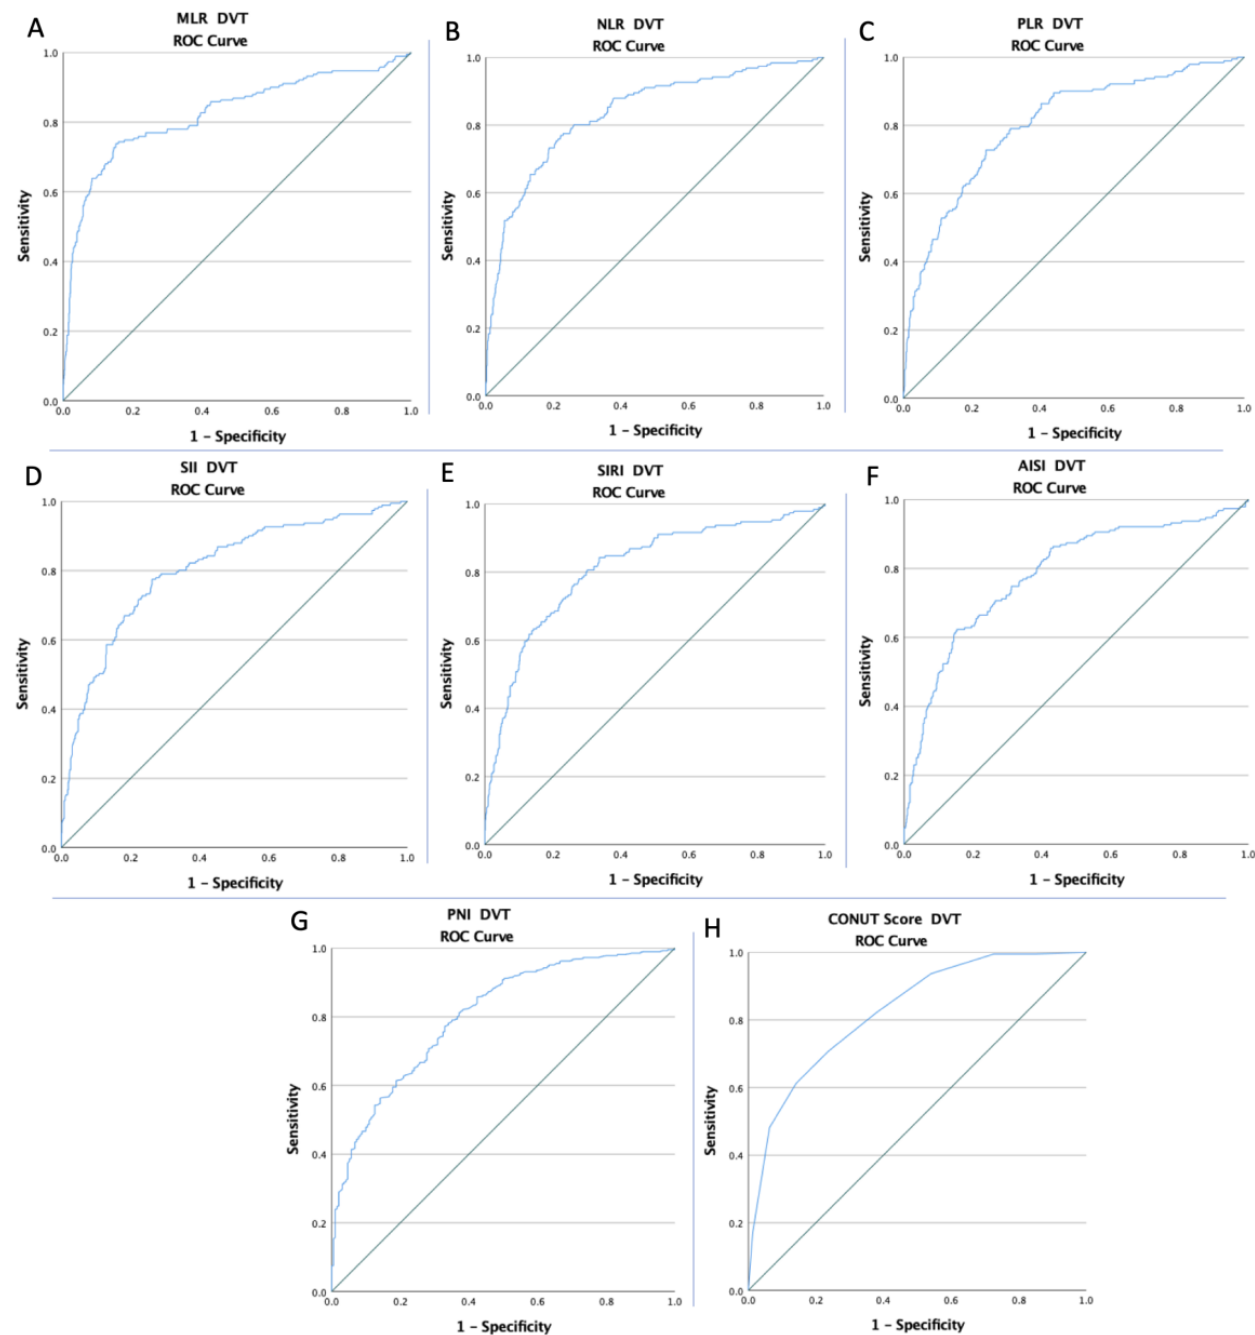
Figure 1. The ROC curve analysis concerning DVT risk ( A ) for the MLR (AUC: 0.824; p < 0.0001), ( B ) for the NLR (AUC: 0.836; p < 0.0001), ( C ) for the PLR (AUC: 0.802; p < 0.0001), ( D ) for the SII (AUC: 0.805; p < 0.0001), ( E ) for the SIRI (AUC: 0.811; p < 0.0001), ( F ) for the AISI (AUC: 0.784; p < 0.0001), ( G ) for the PNI (AUC: 0.803; p < 0.0001), and ( H ) for the CONUT Score (AUC: 0.826; p < 0.0001).